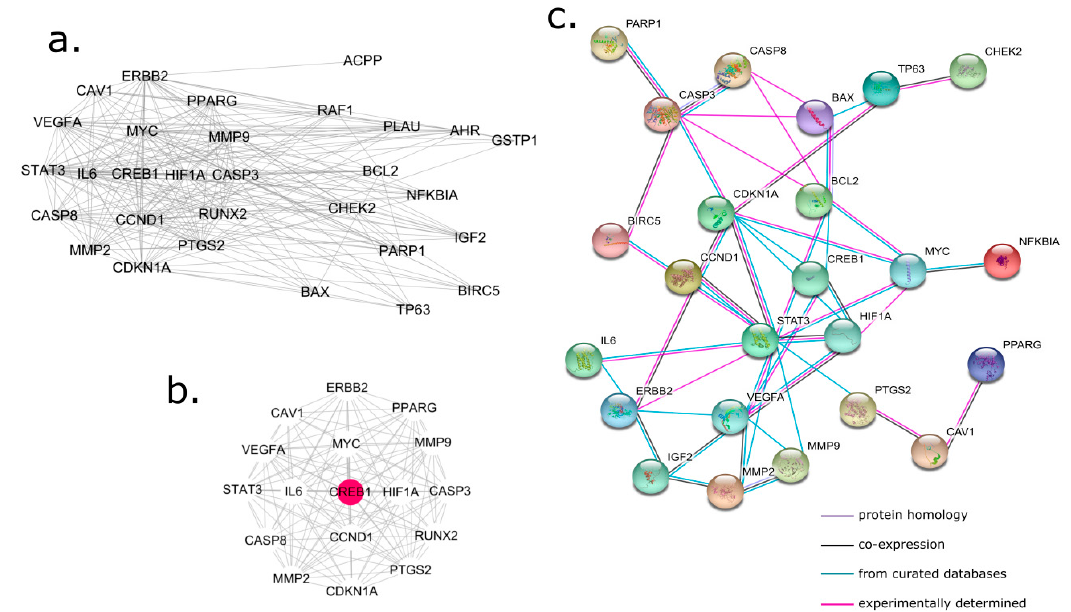
Figure 3. PPI network of HWD compound targets against prostate cancer (PCa). ( a ) The PPI network constructed using Cytoscape (version 3.7.1); ( b ) the cluster generated from (a), where the red target represents CREB1, the seed in this cluster; ( c ) the original PPI data generated from the STRING database showing the detailed interactions of the targets.